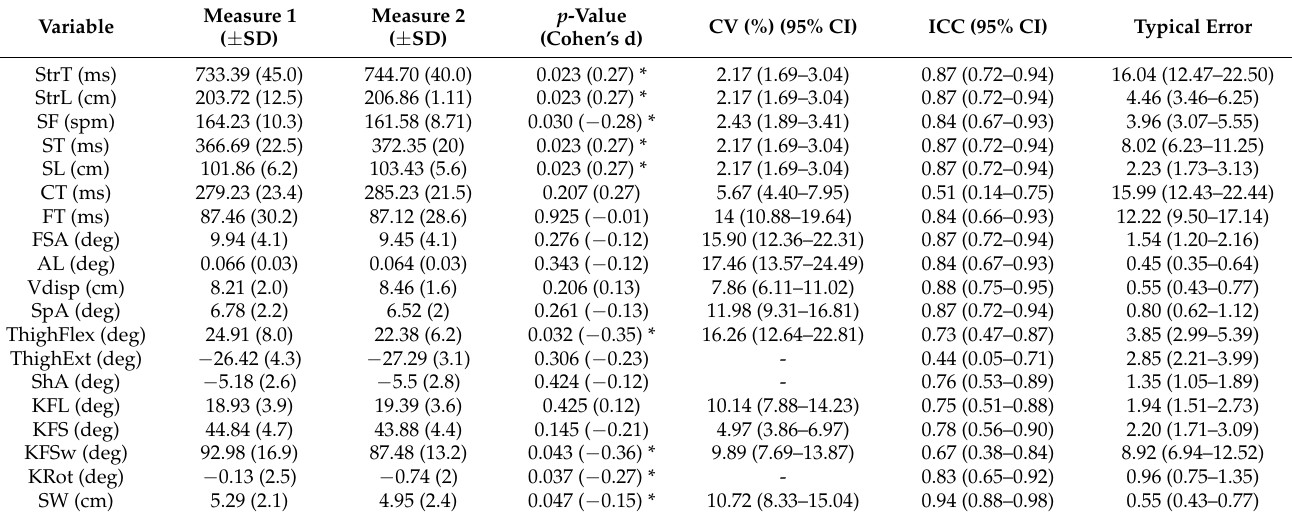
Table 3. Descriptive data (means, ± SD) and inter-session reliability of the kinematic parameters obtained from Kinect + MotionMetrix software running at 10 km · h − 1